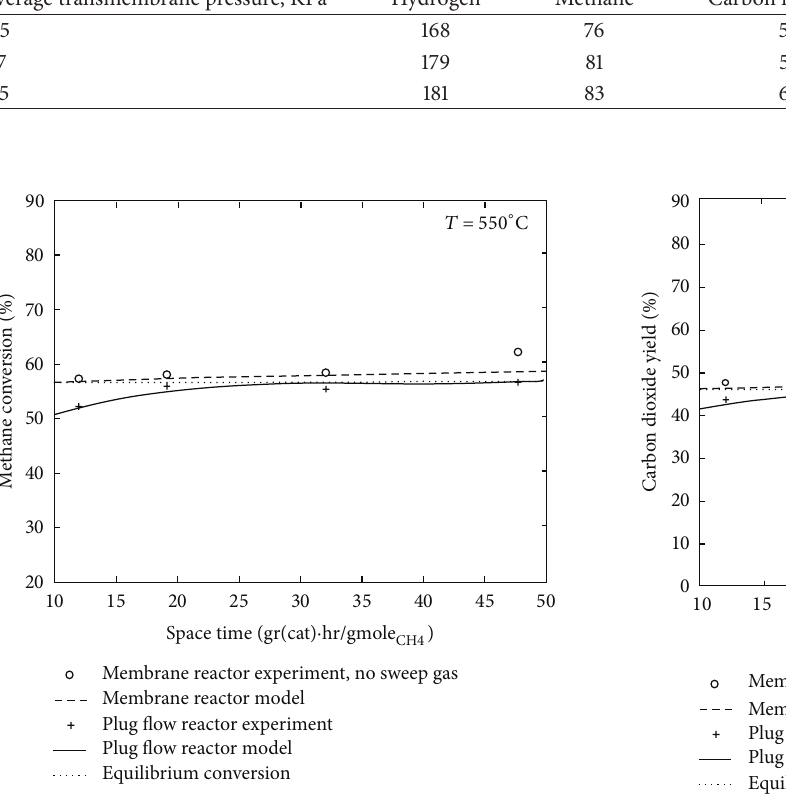
Table 4: Permeability coefficient × 10 2 , mol/m.s.Pa. Experimental measurements at 35 ∘ C for unmodified alumina membrane. Average transmembrane pressure, KPa